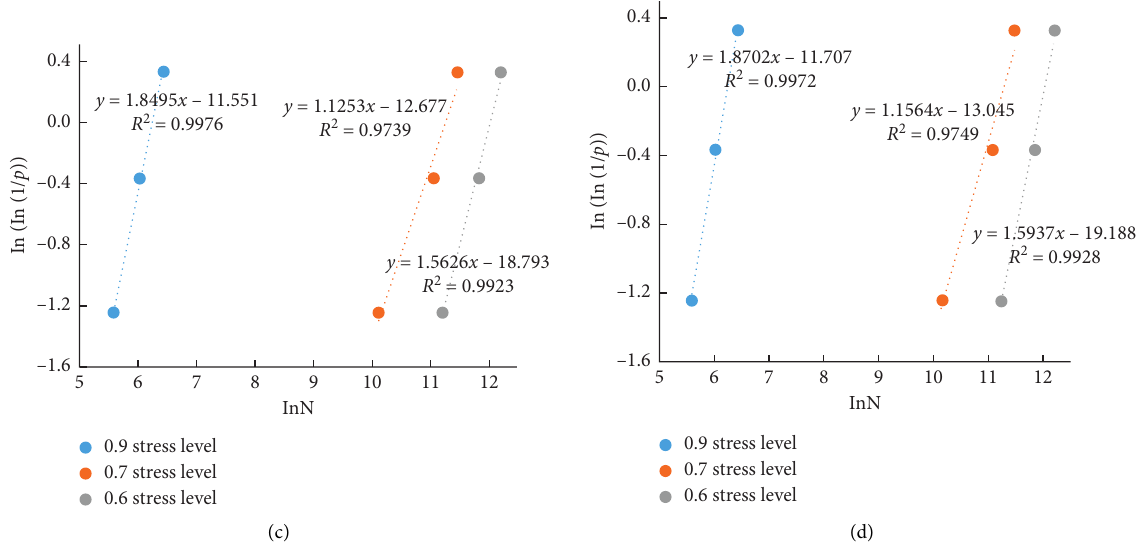
Figure 8: SiCRC linear regression. (a) SiCRC (0d). (b) SiCRC (30d). (c) SiCRC (60 d). (d) SiCRC (90d).